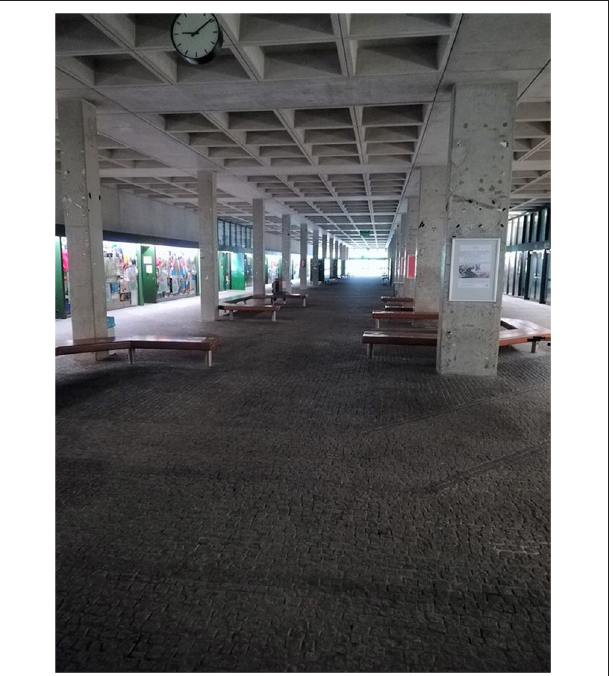
FIGURE 7 | Large hallways are available all over the campus, but there is no encouragement for physical activity (Photo: U2 S41).